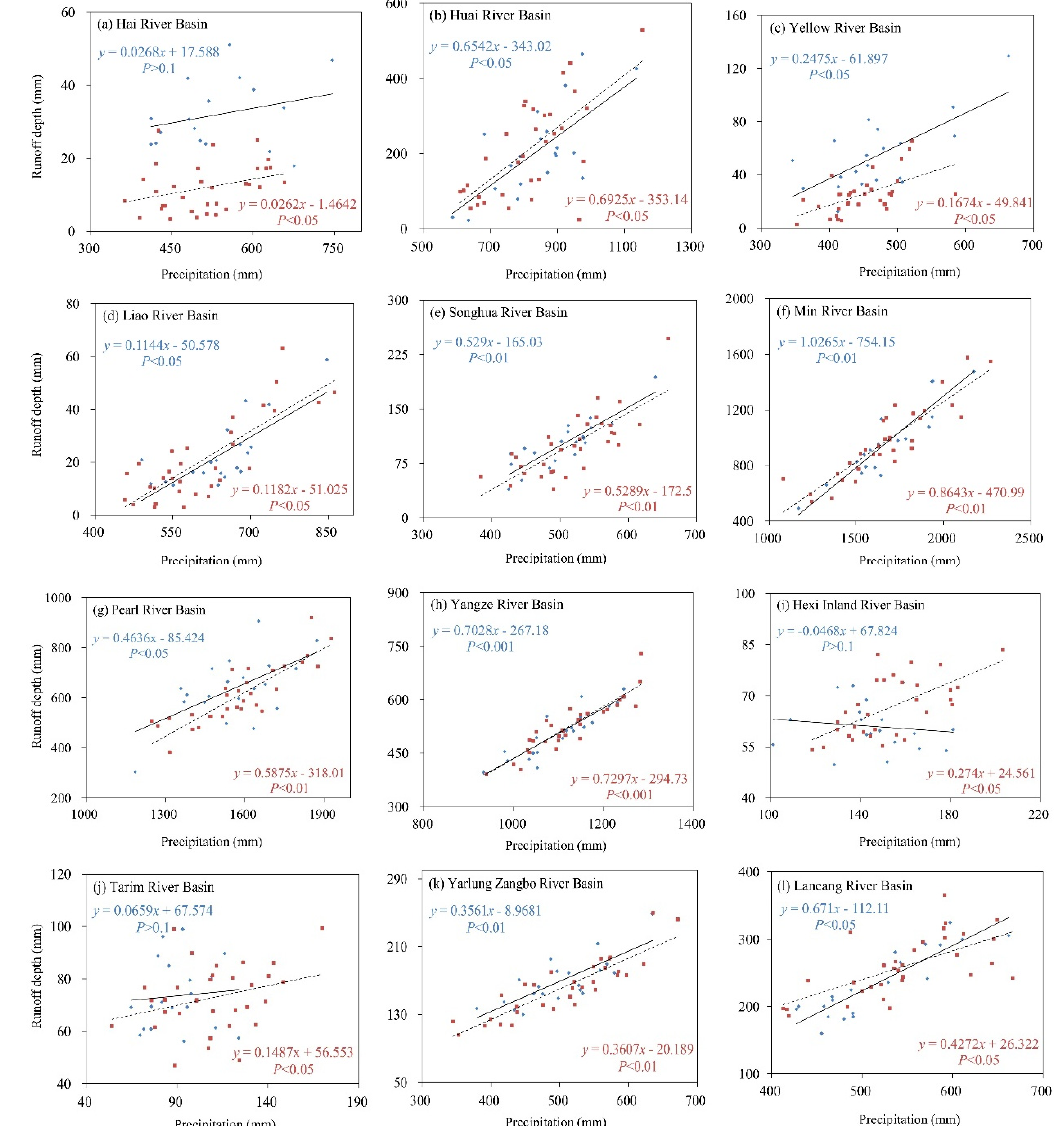
Figure 6. Subsection fitting lines of precipitation versus streamflow in 1950–1979 versus those in 1980–2012. Solid and dotted lines represent lines in 1950–1979 and 1980–2012, respectively. Blue and red points represent data of 1950–1979 and 1980–2012,